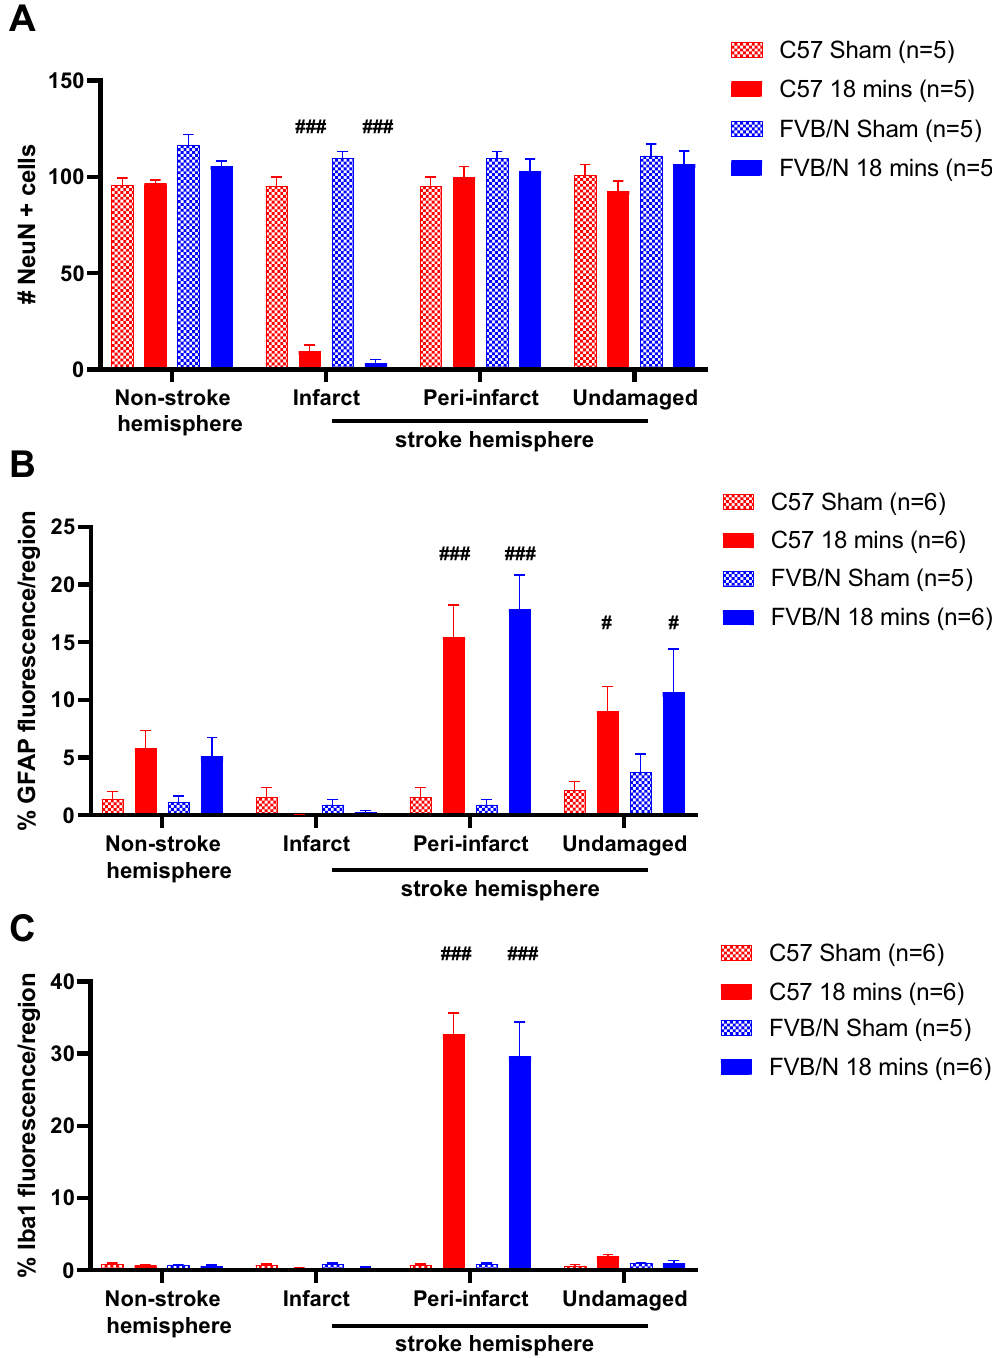
Figure 3. The mean number of NeuN + cells per region, illustrating the number of viable neurons ( A ); the mean percentage of fluorescence per region illustrating the amount of GFAP + staining for reactive astrocytes ( B ); the mean percentage of fluorescence per region of Iba1 + staining for microglia ( C ) in the non-stroke hemisphere, and the infarct, peri-infarct and undamaged regions of the stroke hemisphere in C57Bl/6 and FVB/N mice subjected to 18 min of light exposure during photothrombosis, or sham operated non-stroked mice. Data are represented as mean ± SEM, with # P < 0.05, ### P < 0.001 vs sham, two-way ANOVA followed by Tukey’s multiple comparisons